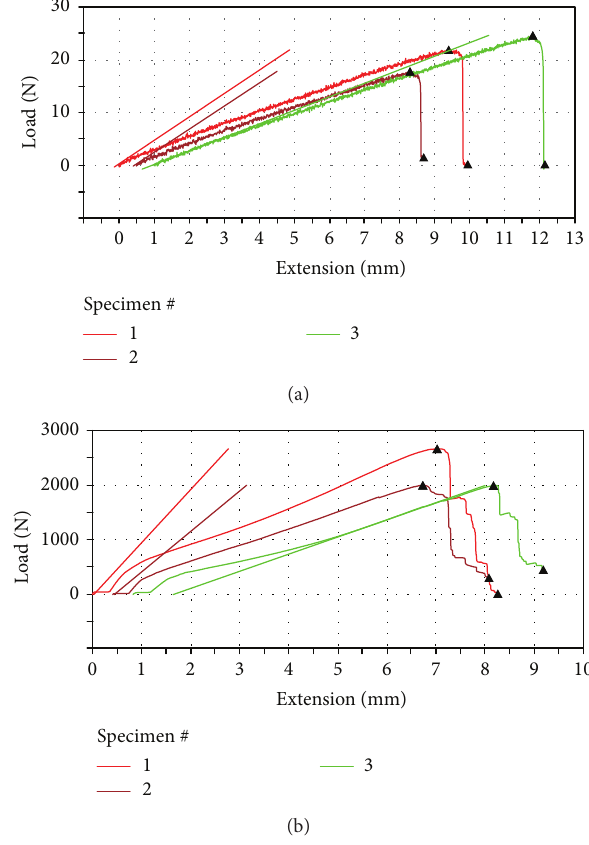
Figure 3: Load-extension diagrams at volume fraction at (a) 0 and (b) 0.5.